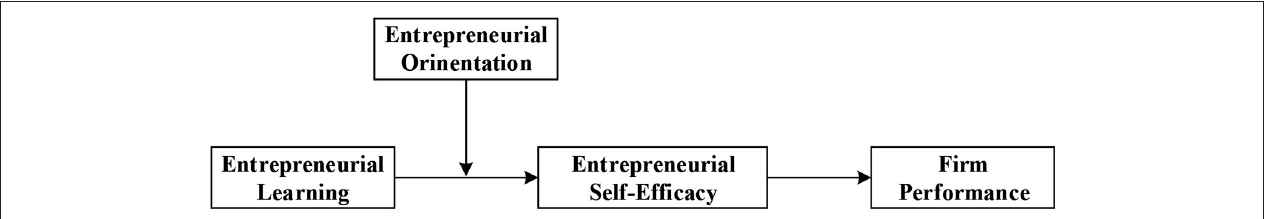
FIGURE 1 | Conception framework of this